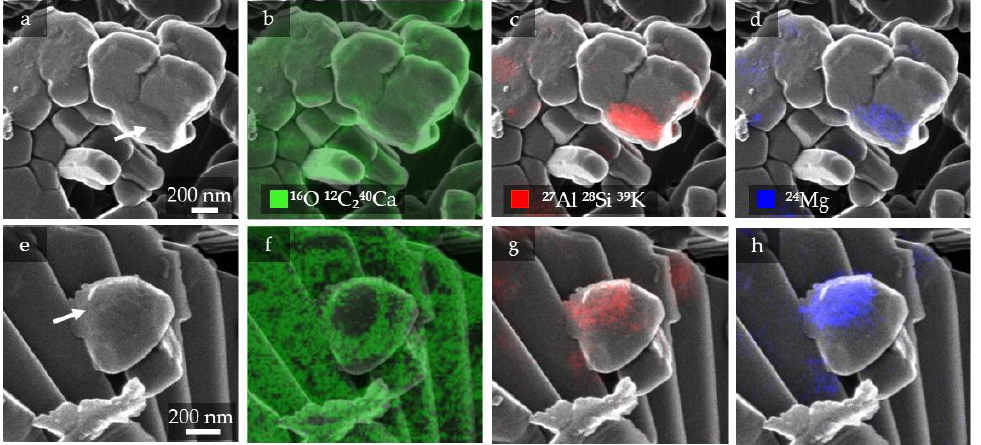
Figure 6. Series of SE and overlay of SE with SIMS results showing mineral phases of coccolith fragments and coating mineral phases, highlighting ²⁴Mg distribution. ( a ) SE image of a coccolith fragment highlighting a location with a slightly different roughness marked by a white arrow. ( b ) Calcite distribution ( 16 O, 12 C₂, and 40 Ca) overlaying the corresponding SE image. ( c ) SIMS detection of ²⁷Al, ²⁸Si, and ³⁹K overlapped with the corresponding SE image. These elements form a sub-micron phase of clay. ( d ) ²⁴Mg distribution. ( e ) SE image discloses a sheetlike feature covering a fragment marked by an arrow. ( f ) SIMS identification of calcite ( 16 O, 12 C₂, and 40 Ca) distribution, overlapping the corresponding SE image. Central absence of calcite. ( g ) The sheetlike mineral has presence of ²⁷Al, ²⁸Si, and ³⁹K representing clay. ( h ) ²⁴Mg is abundant on the sheetlike feature.